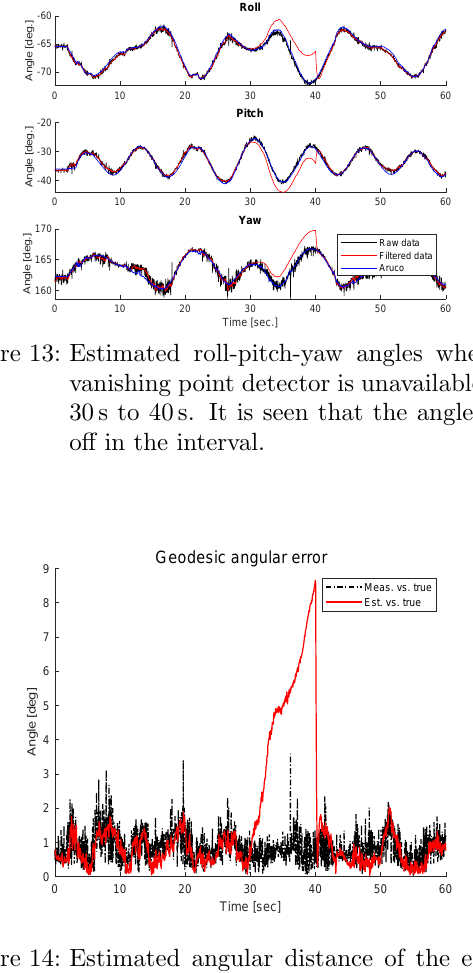
Figure 14: Estimated angular distance of the estima- tion error when the vanishing point detec- tor is unavailable from 30 s to 40 s. It is seen that the angles drift off in the